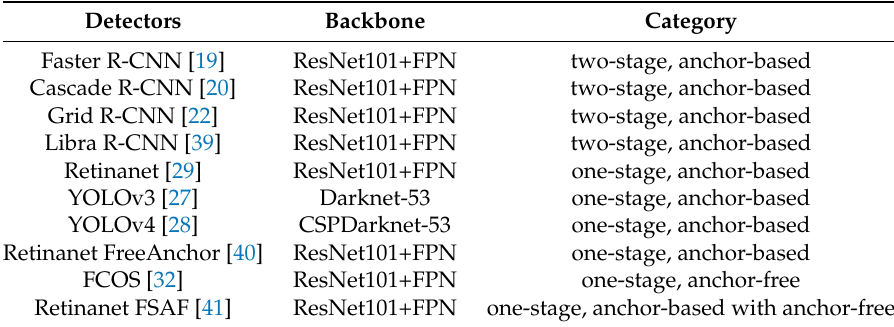
Table 2. Detectors based on deep learning studied in this paper. Eight detectors use ResNet101 [42] + FPN [43] as the backbone, while the other two detectors of YOLO series use Darknet-53 [27] and CSPDarknet-53 [28] as the backbone, respectively. ResNet101 refers to a deep residual network with 101 layers. FPN refers to feature pyramid networks. Darknet-53 refers to a deep residual network with 53 layers and CSPDarknet adds a CSPNet [44] structure on the basis of